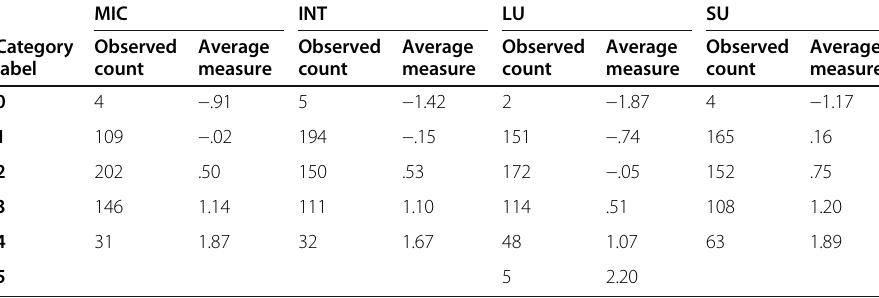
Table 3 FACETS output for rating scale by rubric